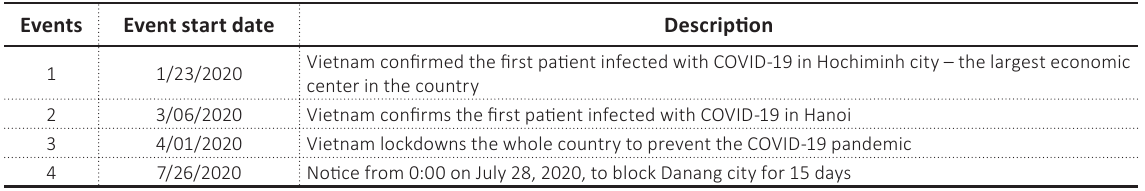
Table 1. Events related to COVID-19 in Vietnam in